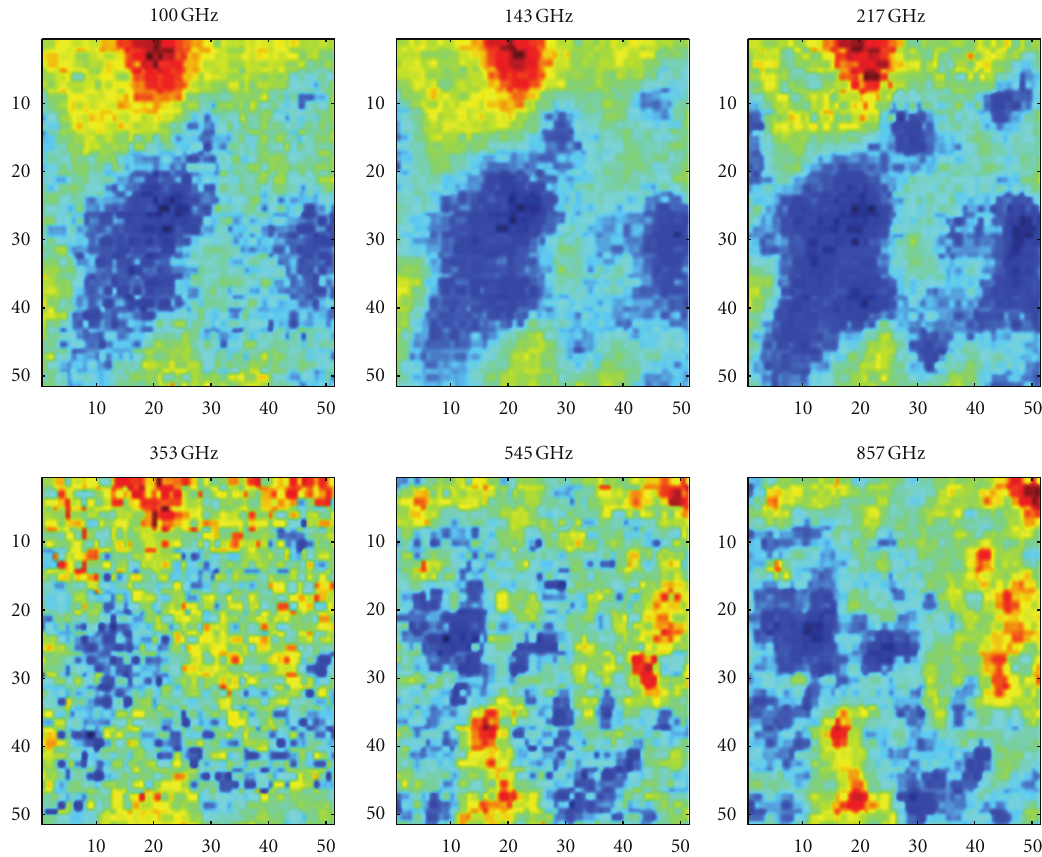
Figure 3: Simulated patches of the sky at 100, 143, 217, 353, 545 and 857 GHz. A bright galaxy cluster is in the centre of the patches, but it is almost invisible among the CMB and Galaxy fluctuations.